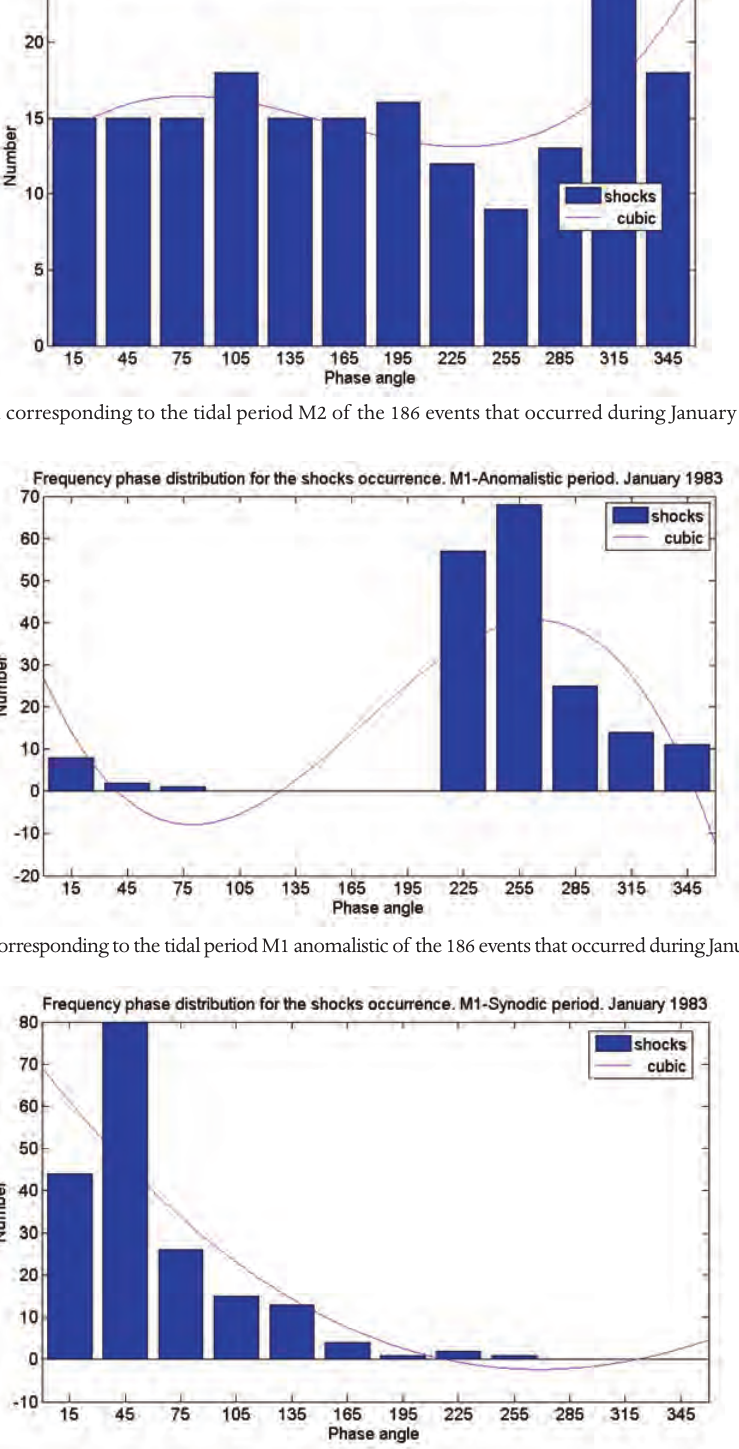
Figure 14. Cumulative histogram corresponding to the tidal period M1 synodic of the 186 events that occurred during January 1983 in the area of Zakynthos.